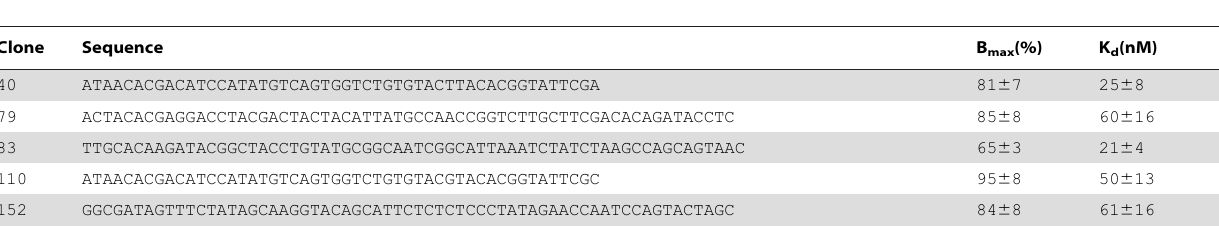
Table 1. The sequences of the random regions of the aptamers tested in neurite outgrowth assays, maximum percent binding (B max ) in our standard assay, and dissociation constants (K d